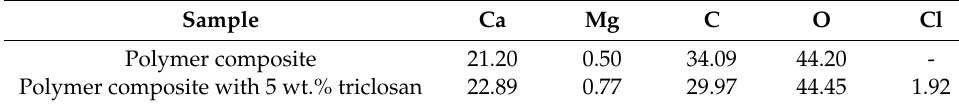
Table 6. The elemental analysis of the polymeric composites on SEM-EDS (in wt.%).